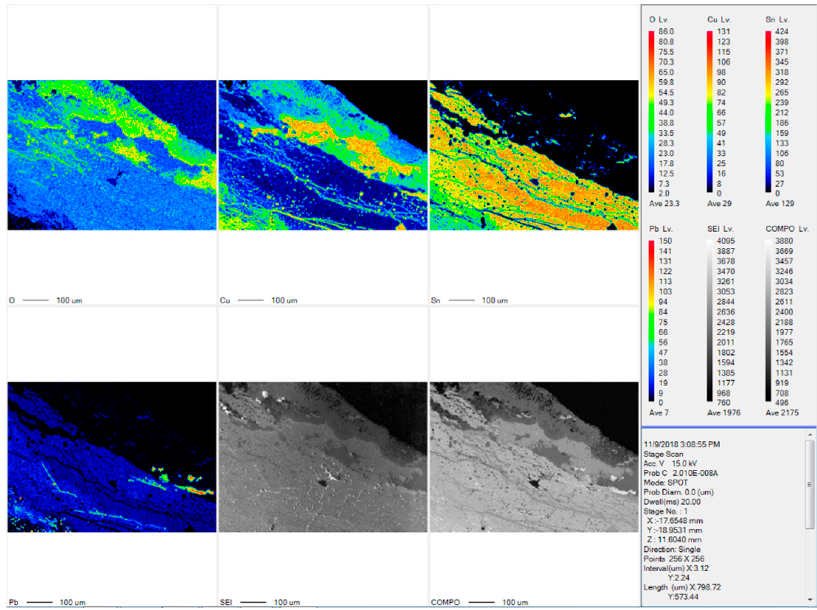
Figure 12. Ga-35 (No. 3) electron probe microanalyzer (EPMA) mapping image.